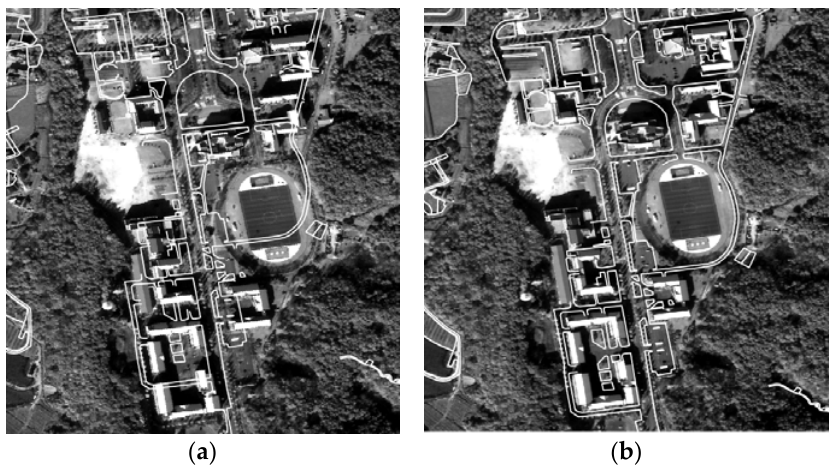
Figure 6. Overlay of map layers and VHR image: ( a ) before and ( b ) after the bias ‐ compensation.